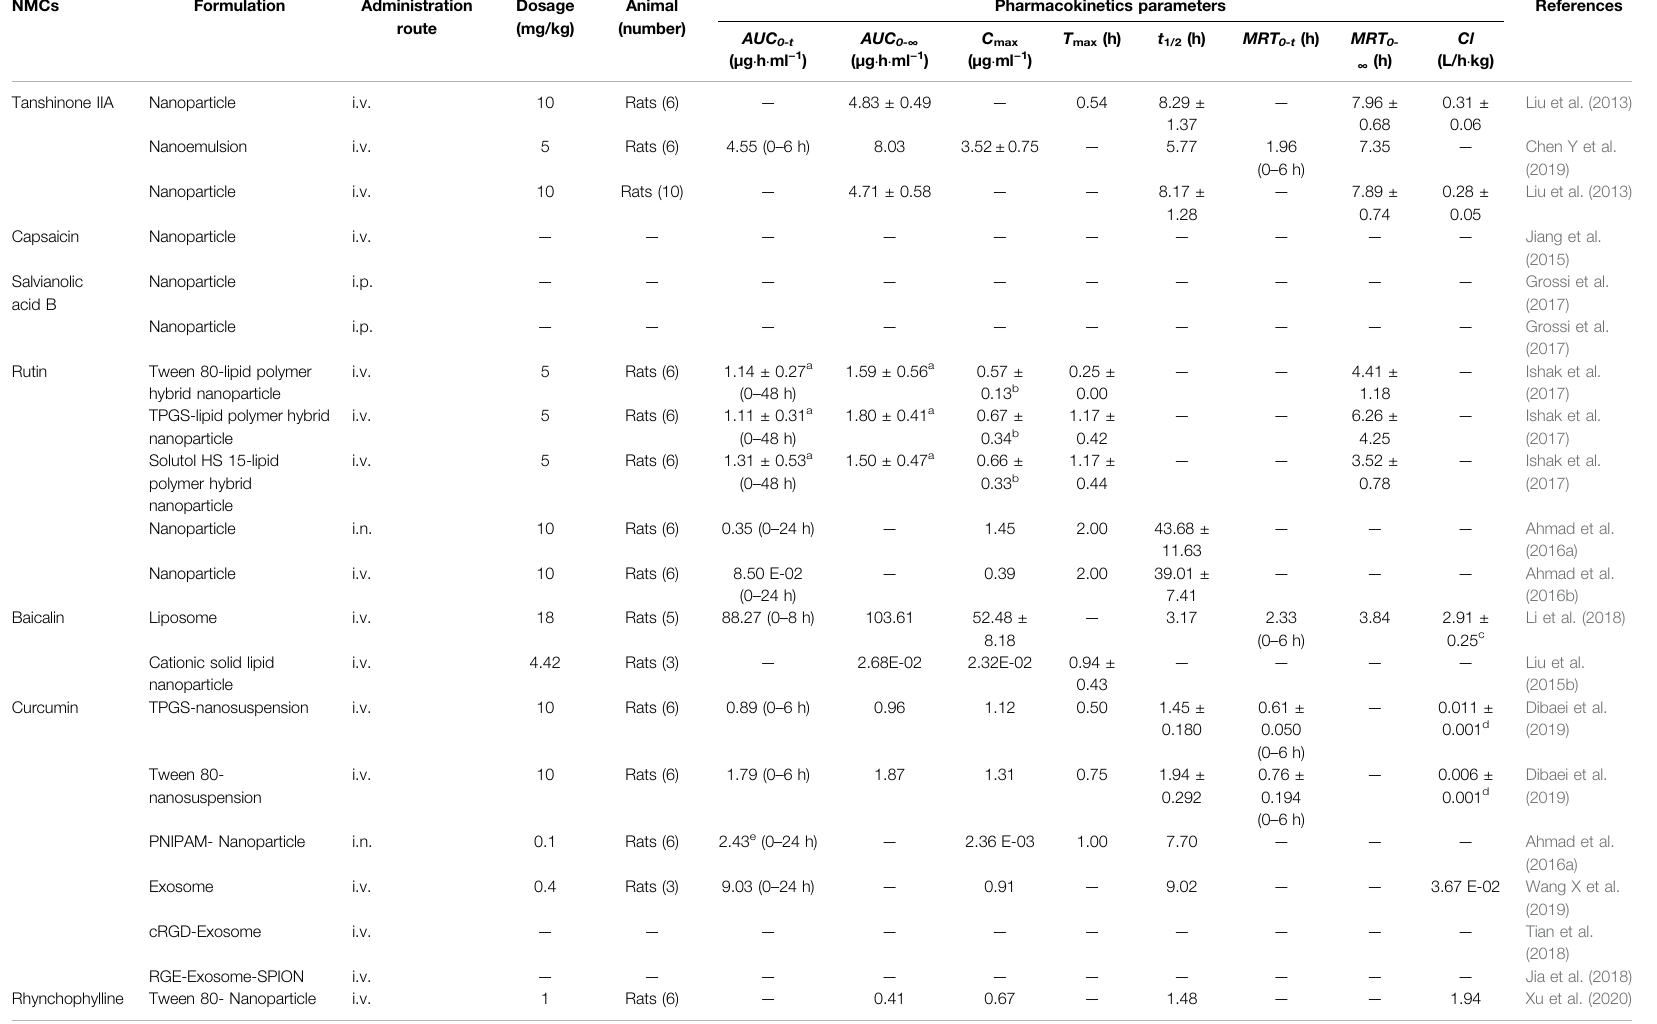
TABLE 2 | | Pharmacokinetic characteristics of NMC-DDS. NMCs